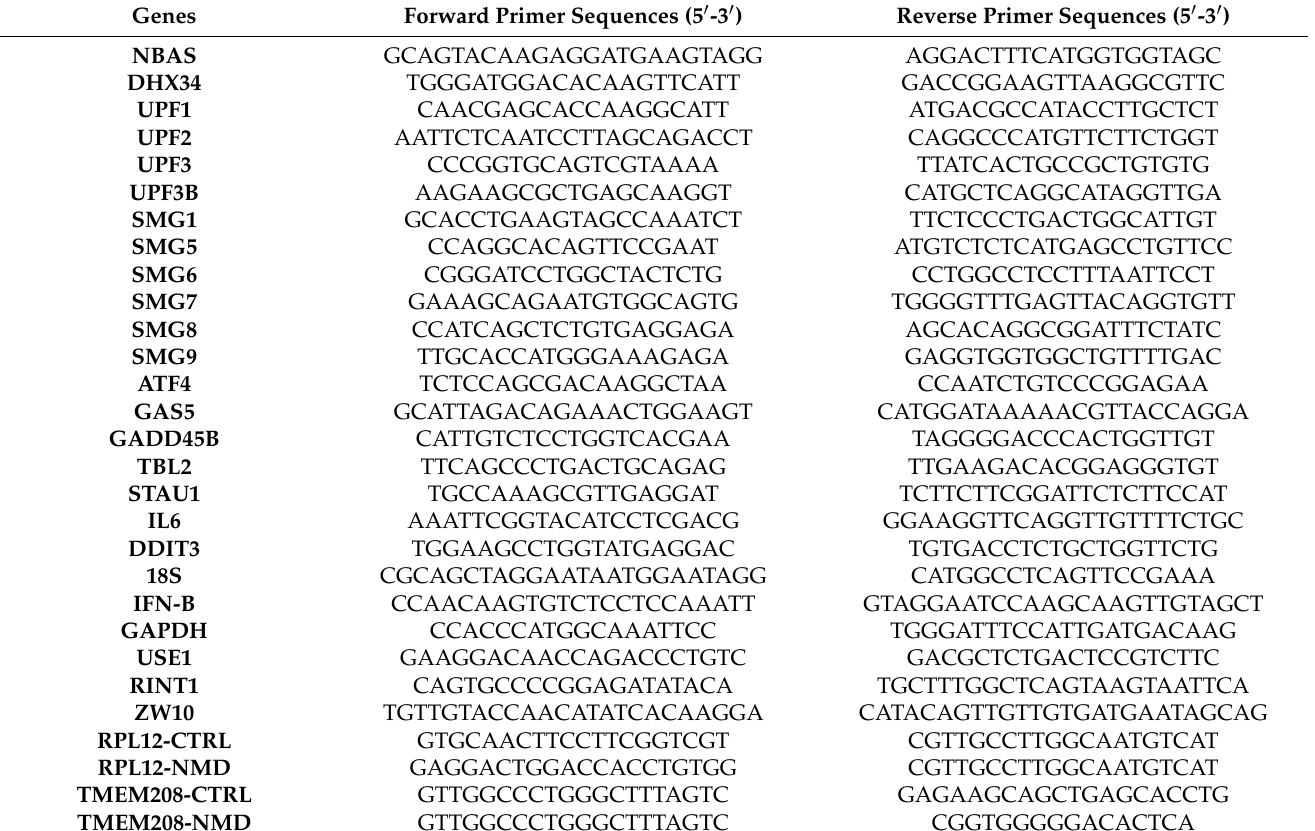
Table 1. Primers used for qRT-PCR